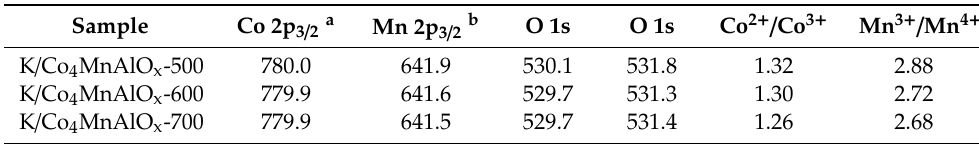
Table 2. Binding energies of core level electrons of catalysts and molar ratios of Co 2 + / Co 3 + and Mn 3 + / Mn 4 + ions.